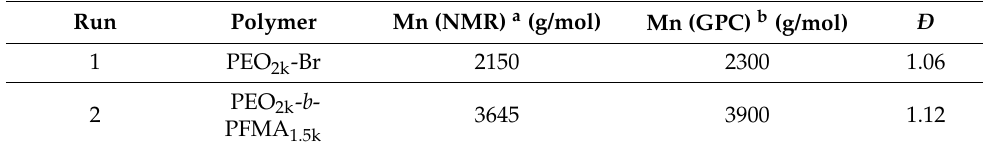
Table 1. Characteristic data of PEO 2k - b -PFMA 1.5k copolymer.